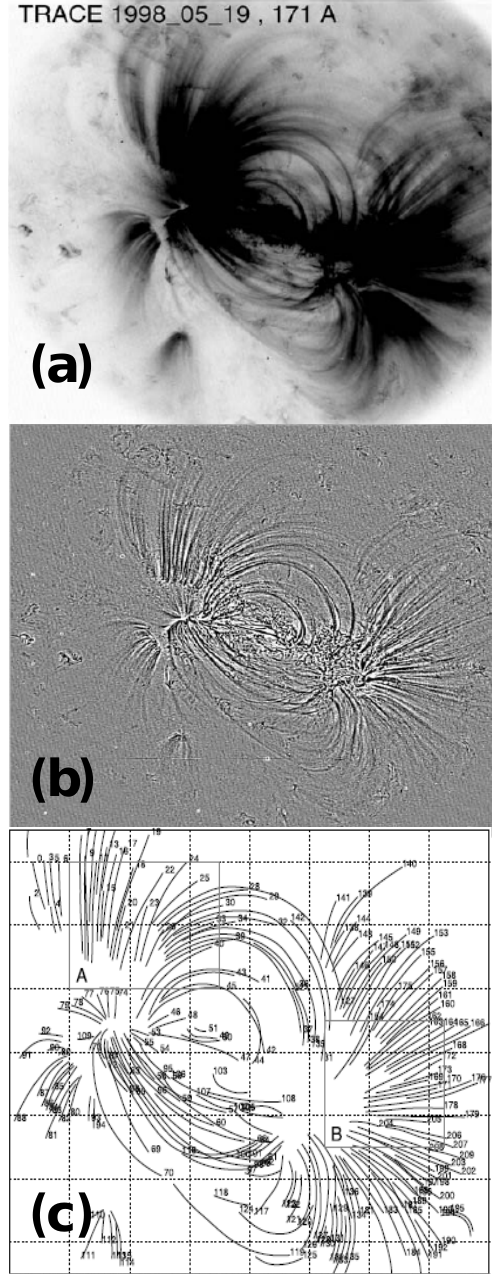
Fig. 1. Panel (a) shows an original 171 ˚A TRACE image of 19 May 1998, panel (b) a corresponding high-pass-filtered image, where a 7 × 7-boxcar smoothed image was subtracted from the original. The image has been used to compare the output of five feature recog- nition codes with the result of 210 manually traced loop shown in panel (c) (original figures are from Aschwanden et al., 2008a, Figs. 1 and